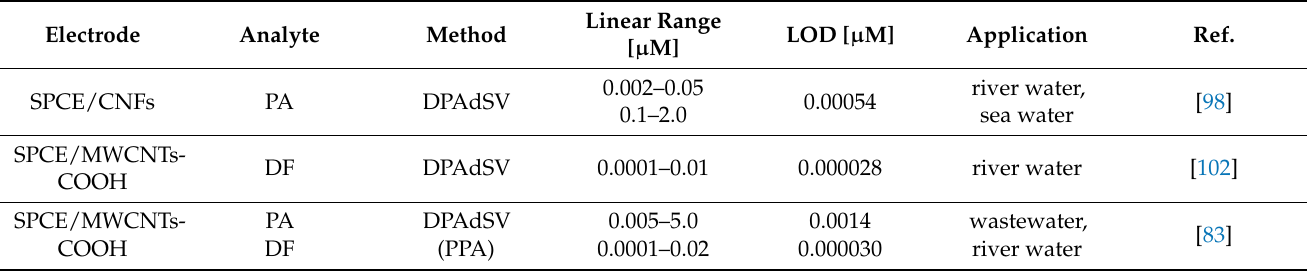
Table 2. Summary of voltammetric procedures to determine painkillers residues at the screen-printed electrodes modified with carbon materials in environmental water